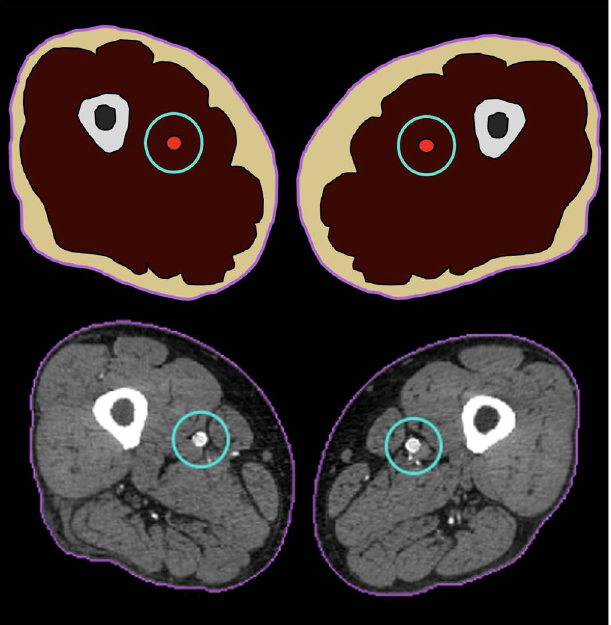
Figure 2. The three defined ROIs, schematic (up) and slice example (down): the PROI (blue circle) is centered around the arteries; the SROI (purple circle) defines the body, excluding the PROI; and the background includes the rest of the image.